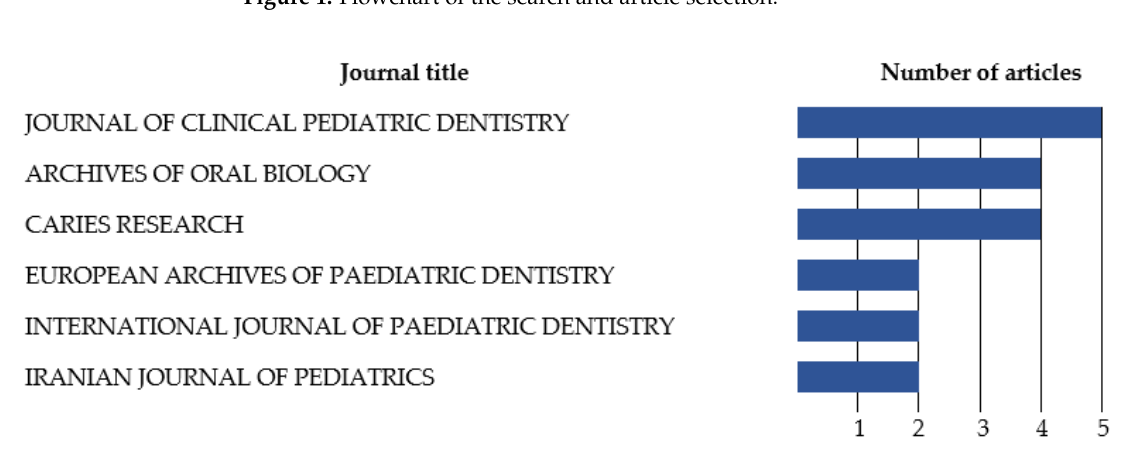
Figure 1. Flowchart of the search and article selection.